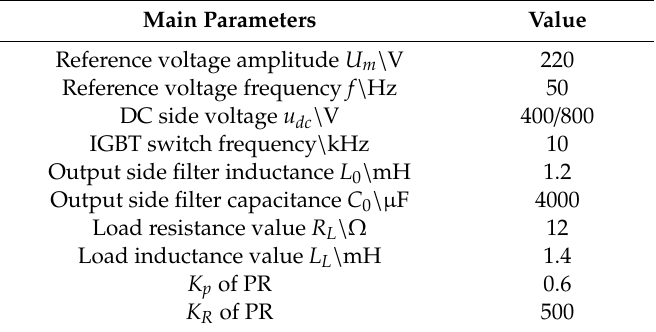
Table 3. The main parameters of the simulation model.